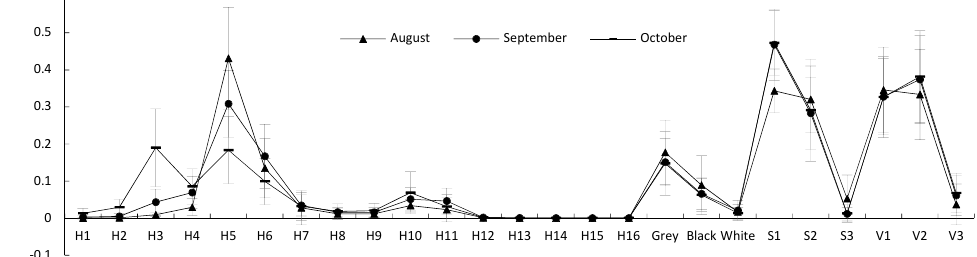
Figure 4. Proportion of color elements in autumn.